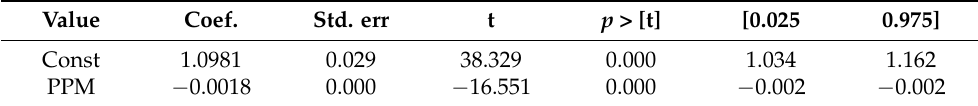
Table 4. OLS regression results (MQ4 continued).